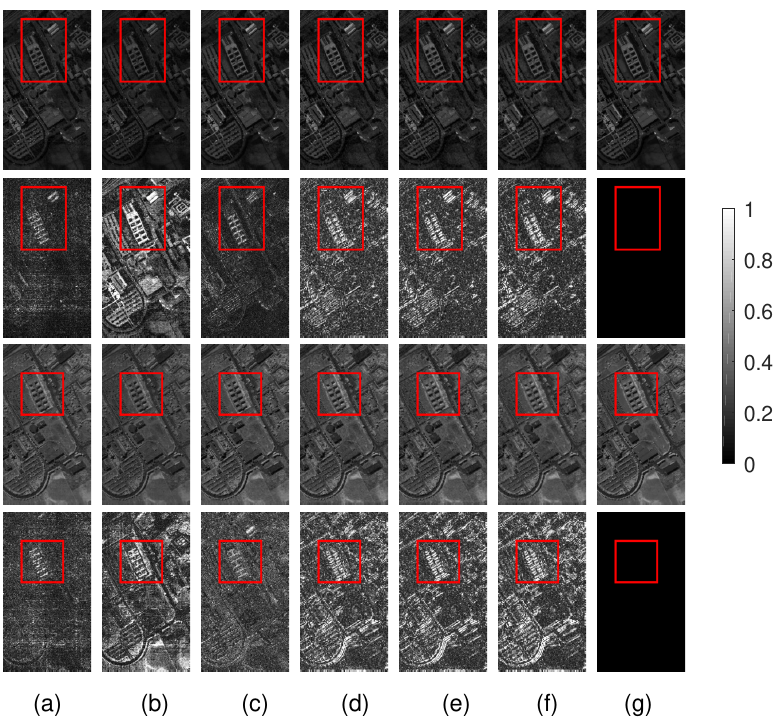
Figure 5. Reconstructed images and corresponding error images of Pavia University for the 50th and 100th bands with unknown D H and noisy D M : ( a ) JTF; ( b ) Blind STEREO; ( c ) CNMF; ( d ) SFIM; ( e ) MTF-GLP; ( f ) MAPSMM; ( g ) ground